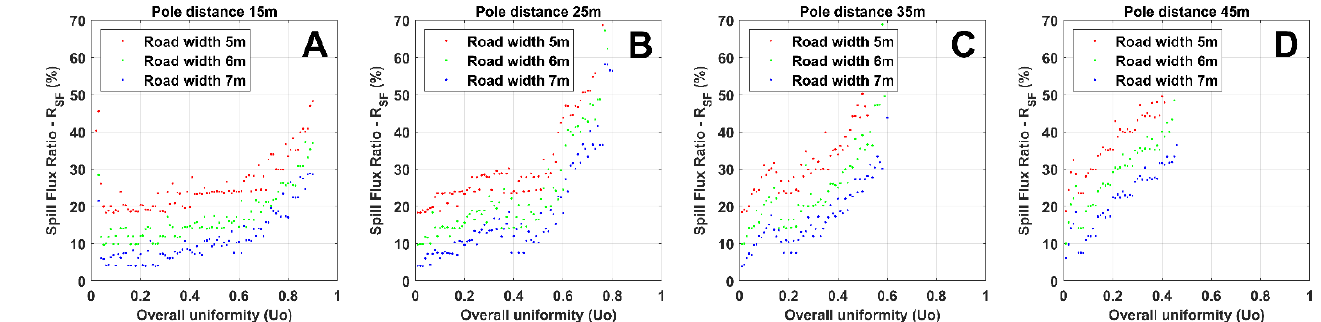
Figure 17. Overall uniformity of illuminance vs. minimum spill flux ratio for key pole distances. All plots have a vertical scale in percentage of spill luminous flux of up to 70% for a better comparison: ( A ) results for pole distance of 15 m; ( B ) results for pole distance of 25 m; ( C ) results for pole distance of 35 m; ( D ) results for pole distance of 45 m.